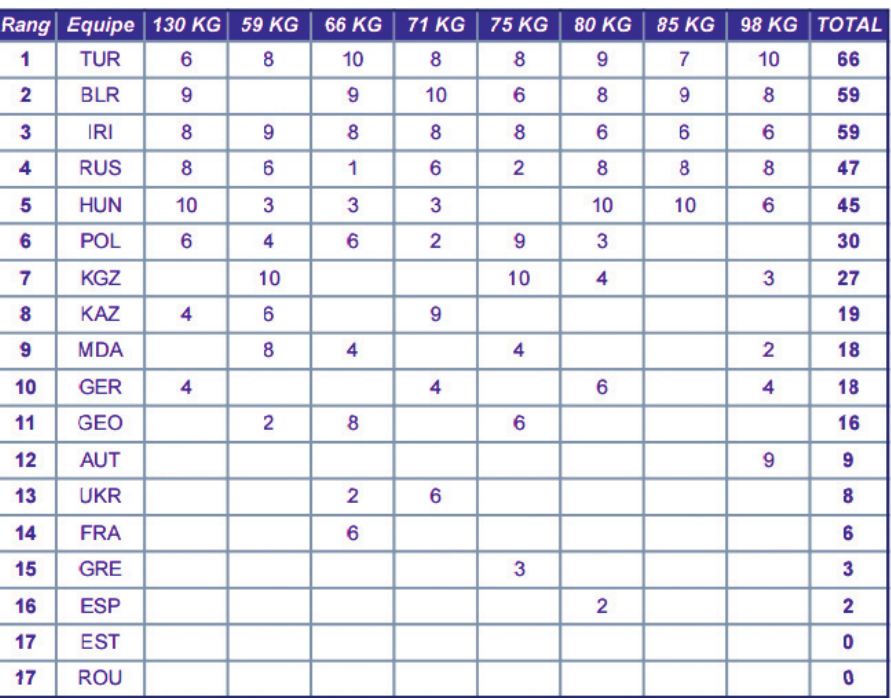
Reference: Turkish University Sport Federation (2016).